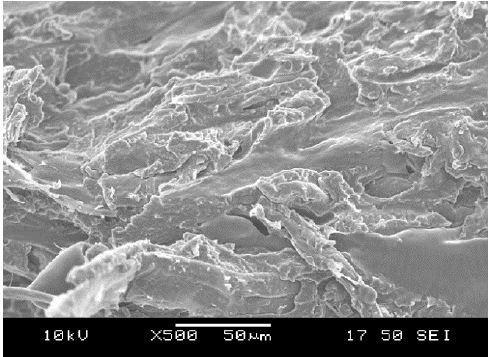
Figure 8. Scanning electron microscopy (SEM) picture taken from the fracture surface of a thermoplastic starch (TPS) containing microfibrillar cellulose (10 wt%) and natural rubber (NR) (10 wt%). The deformed NR particles’ surface is